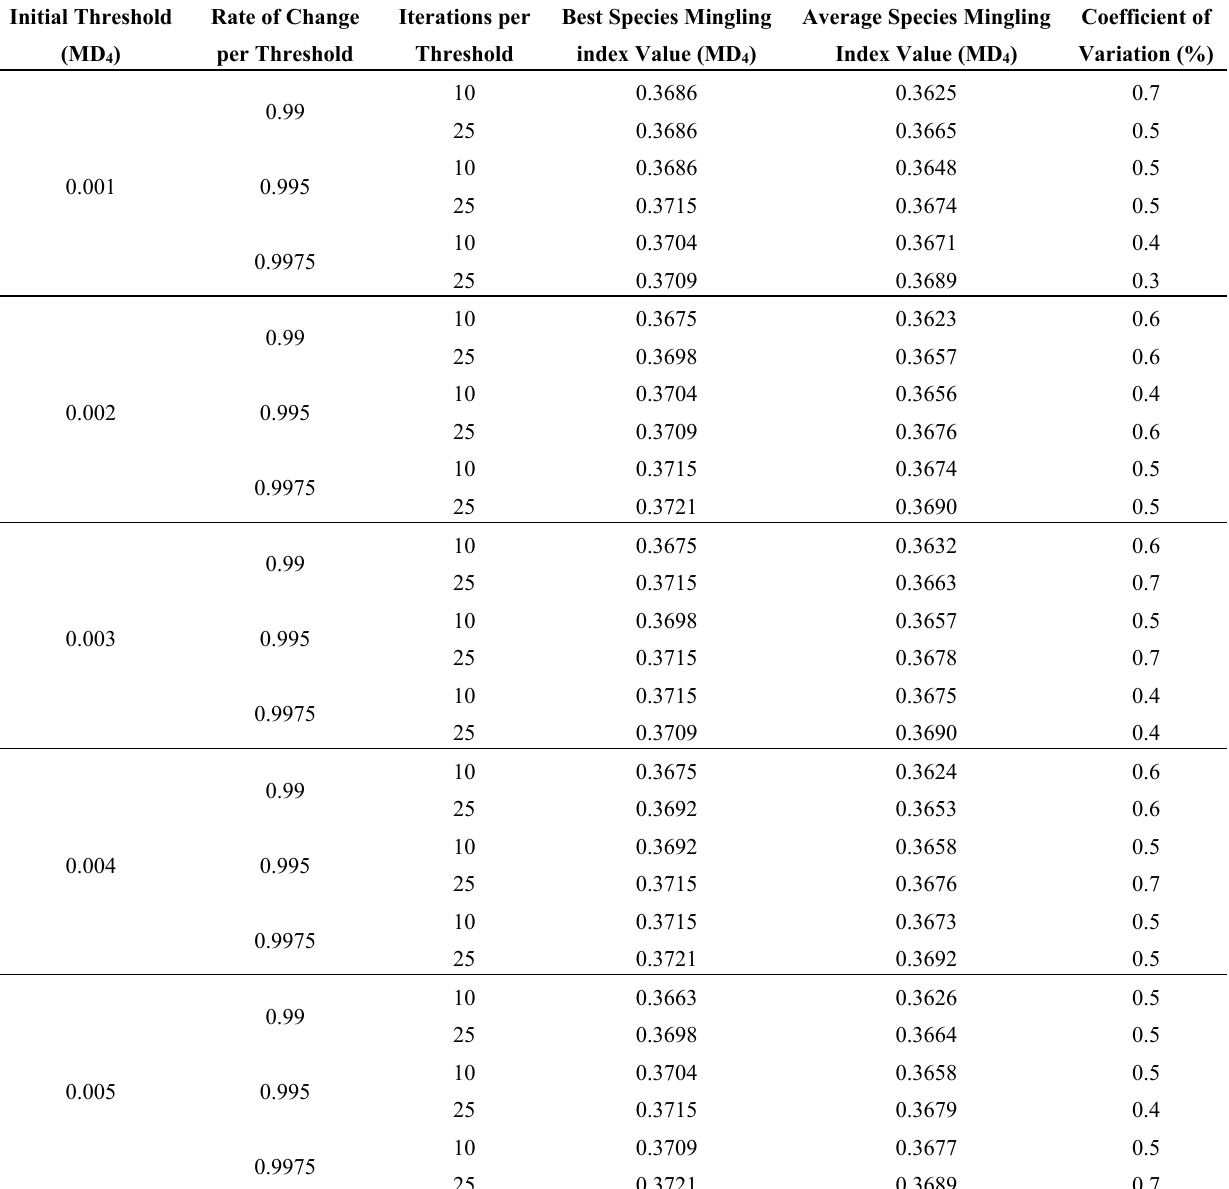
Table 5. Results of the application of threshold accepting to a tree-level harvest schedule of an uneven-aged mixed-conifer stand in eastern Oregon (western United States), based on maximizing the species mingling index and using non-unique tree species as